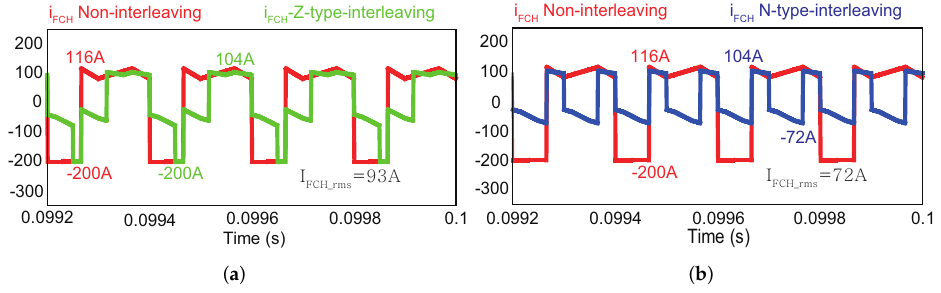
Figure 17. ( a ) Capacitor current for Z-type interleaving; ( b ) capacitor current for N-type